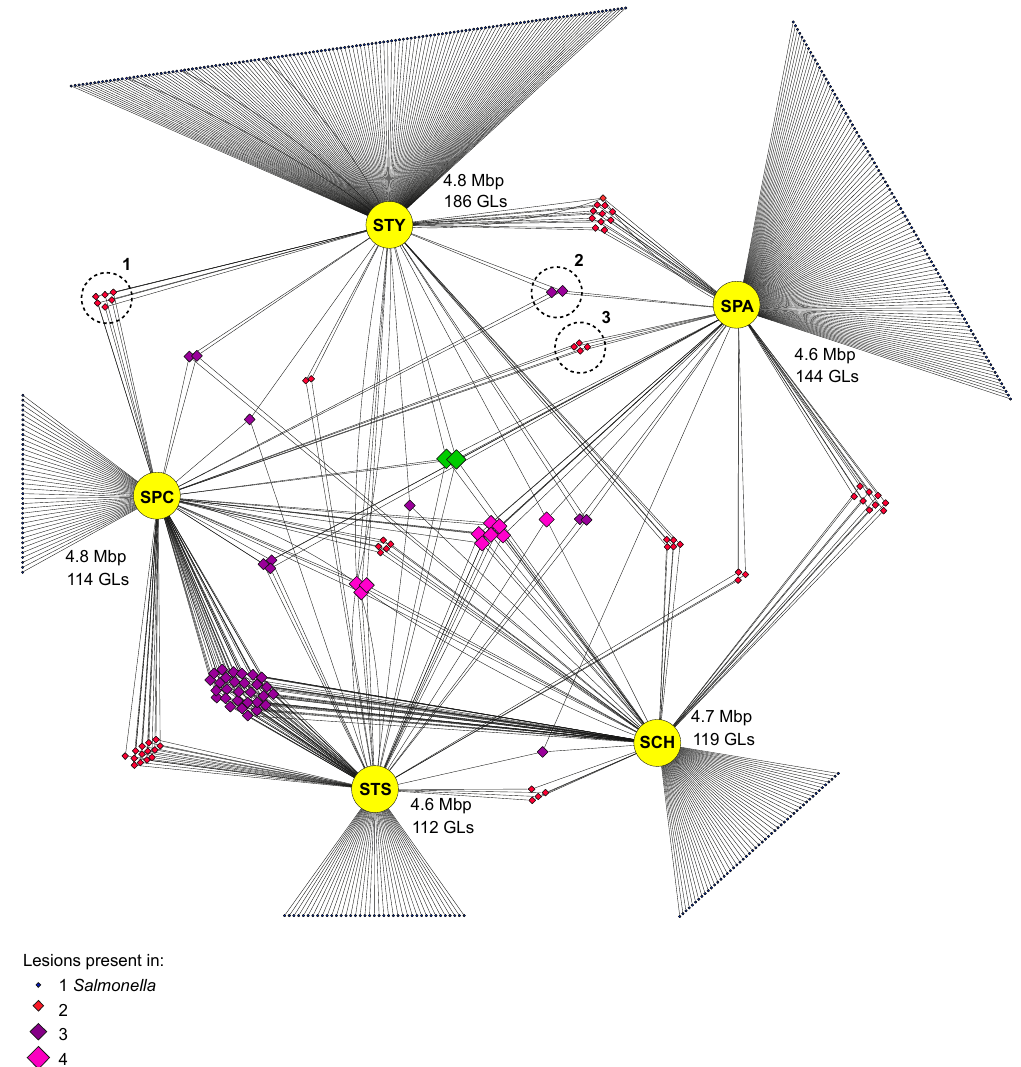
Figure 2. Distribution of disrupted genes. Network of shared and unique disrupted genes in S. Paratyphi C (SPC), S. Typhisuis (STS), S. Choleraesuis (SCH), S. Paratyphi A (SPA) and S. Typhi (STY). Yellow circles are false nodes representing each Salmonella . Diamonds indicate a single genomic lesion; size and colour indicate how many Salmonella share that lesion. Black lines connect Salmonella to genomic lesions. Lesions unique to each Salmonella are shown as fans around the false nodes. Mbp, megabase pairs; GL, genomic lesion. Dashed circles indicate lesions shared between SPC and STY and/or SPC and SPA. 1: torC , ratC , STY4541, STY2432, STY1834, STY1781; 2: slrP and fliB ; 3: STY4472, STY4044, STY1408, STY1353.